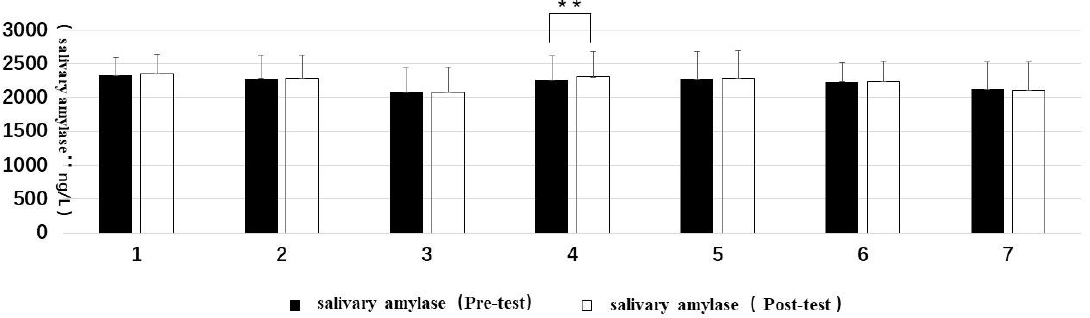
Figure 4. Pre- and post-test of salivary amylase: ( 1 ) structure, ( 2 ) wood, ( 3 ) wood with bench, ( 4 ) wood with platform and bench, ( 5 ) platform with trees, ( 6 ) waterfall with trees, and ( 7 ) pool with plants. Interpretation: ** means p < 0.01.